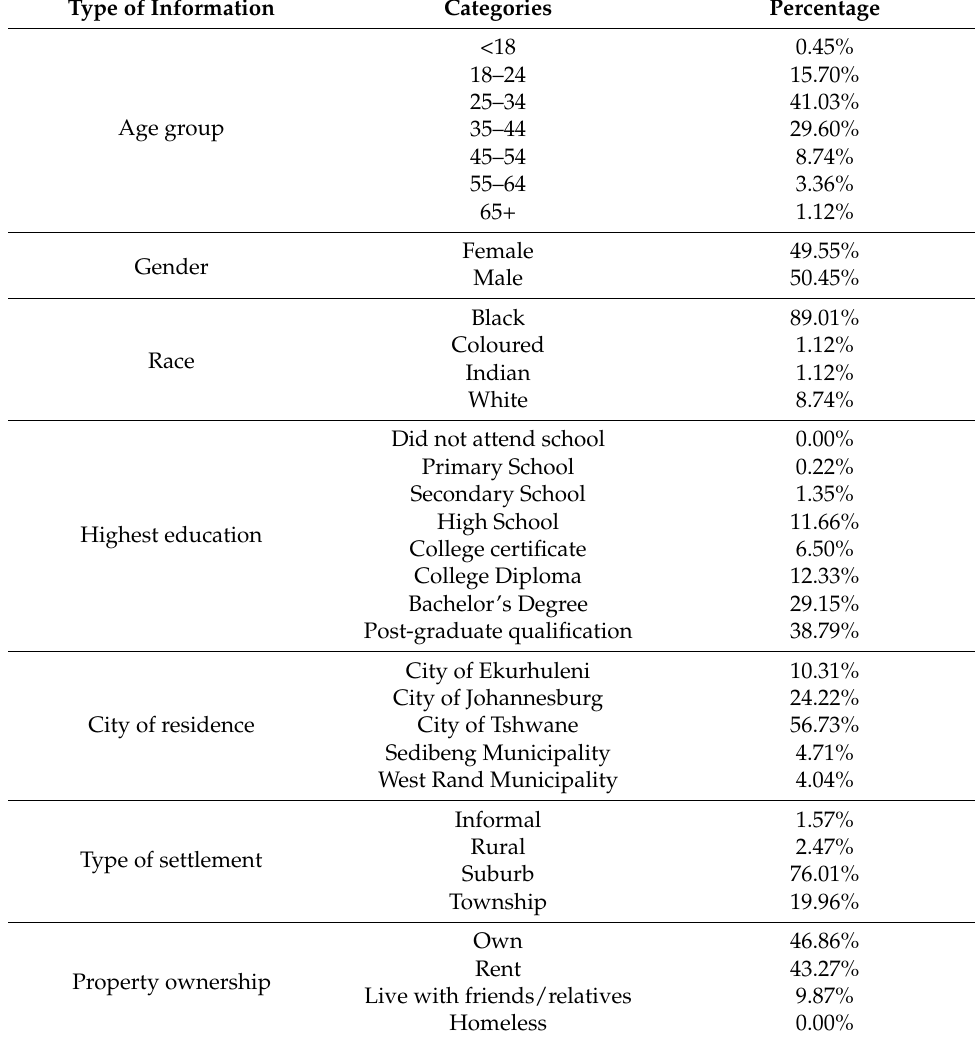
Table 2. Basic information obtained from the